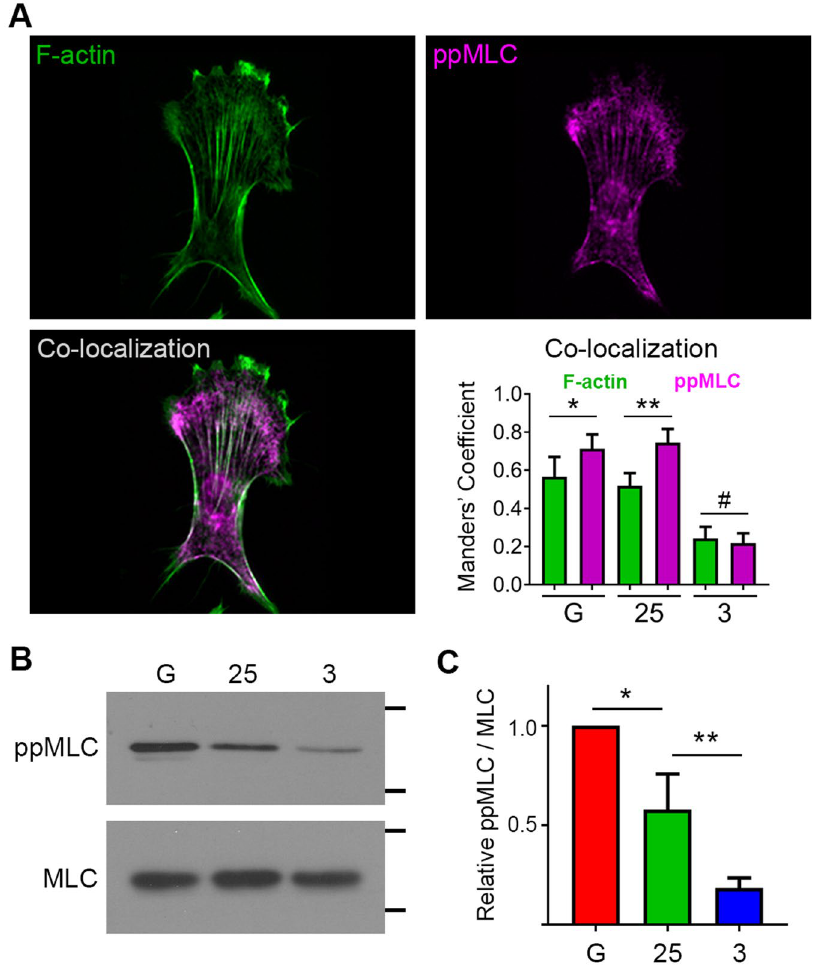
Figure 3. Substrate rigidity enhances actin-myosin co-localization and myosin phosphorylation. ( A ) SKOV-3 cells plated on FN-coated glass ( G ), 25 kPa, or 3 kPa hydrogels were fixed and stained to visualize F-actin and dually-phosphorylated myosin light chain (ppMLC). Images of a representative cell on 25 kPa hydrogel are shown ( n.b . this is the same cell shown in Fig. 2). Co-localization of F-actin and ppMLC was assessed by pixel-by-pixel image correlation analysis performed using intensity correlation analysis to produce Mander’s correlation coefficients. Average Mander’s coefficients are plotted as mean ± SEM (n = 15 cells; * p = 0.0015 using Wilcoxon test; ** p < 0.0001 using Wilcoxon test; #, no significant difference between Manders’ coefficients for F-actin and ppMLC on 3 kPa gels, while the coefficients for both F-actin and ppMLC on 3 kPa are significantly different ( p < 0.0001, unpaired t-test) than the corresponding values on 25 kPa and glass). ( B ) Lysates from SKOV-3 cells plated on the indicated substrates (as in panel (A)) were separated by SDS-PAGE and probed with antibodies against ppMLC (Thr18/Ser19) and total myosin light chain (MLC). The positions of the 20 kDa and 15 kDa molecular weight markers are indicated. ( C ) The relative ratio of ppMLC to total MLC was determined by densitometry (mean ± s.d.; n = 6; * p = 0.005; ** p = 0.006, using a Mann-Whitney